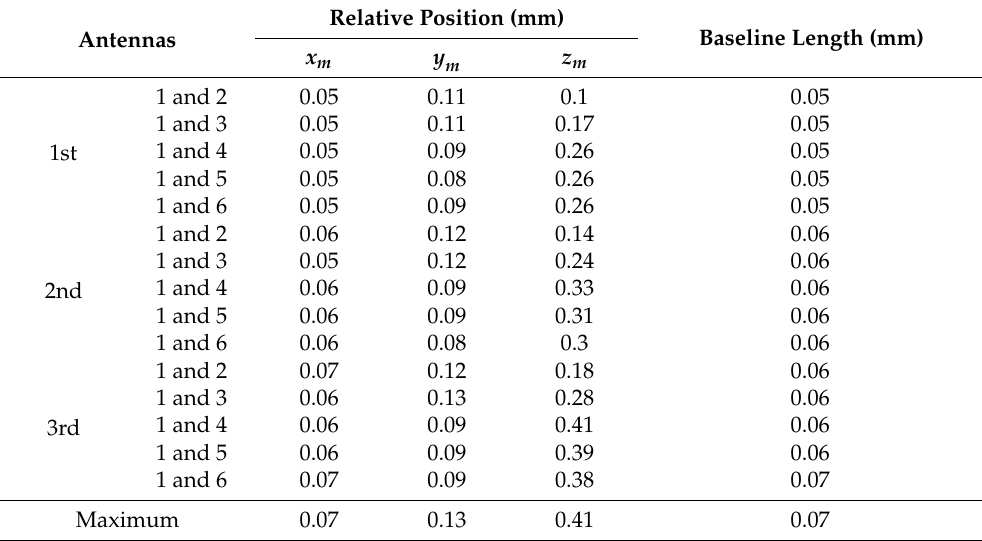
Table 3. Error statistical results of relative motion between antennas. Relative Position (mm) Antennas